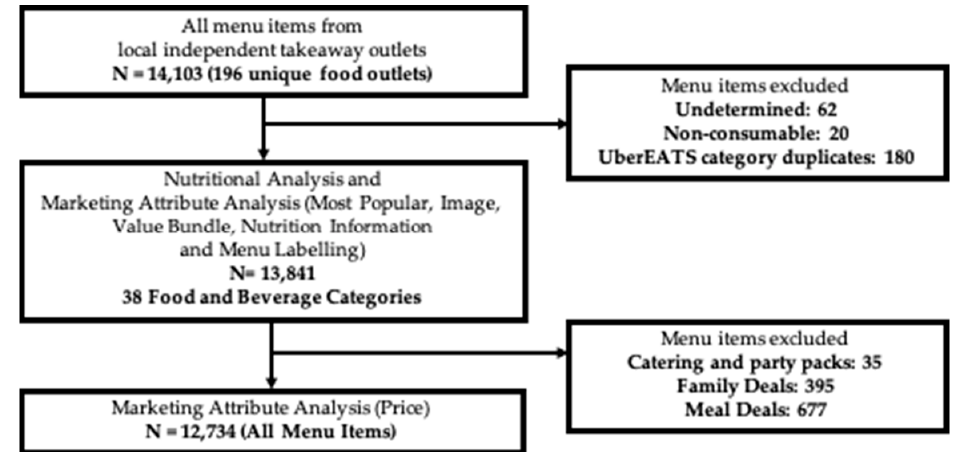
Figure 1. Flow diagram outlining inclusion of menu items in each analysis.